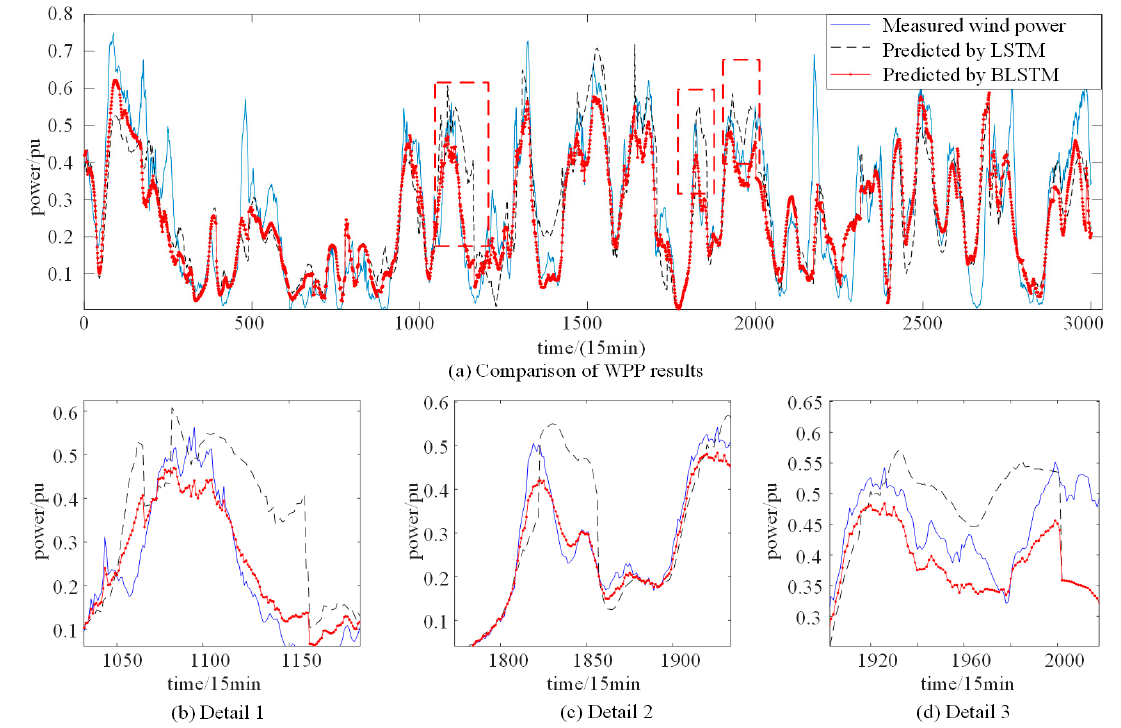
Figure 14. Comparison of WPP results of LSTM and BLSTM (one day in advance, 750 h WPP).